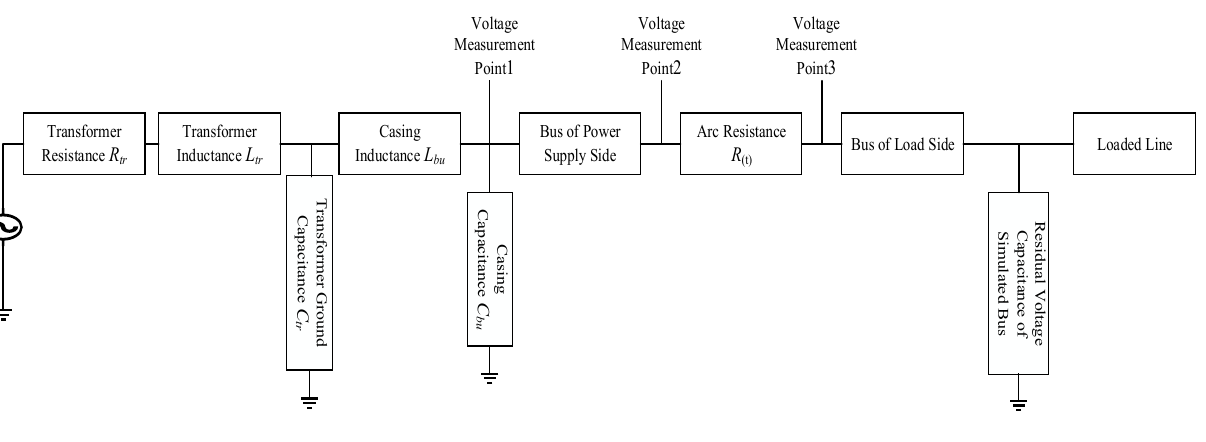
Figure 3. VFTO simulation model block diagram.